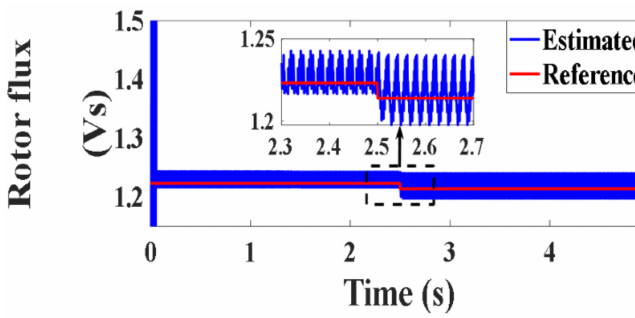
Figure 34. Rotor flux under MPCC (Vs).